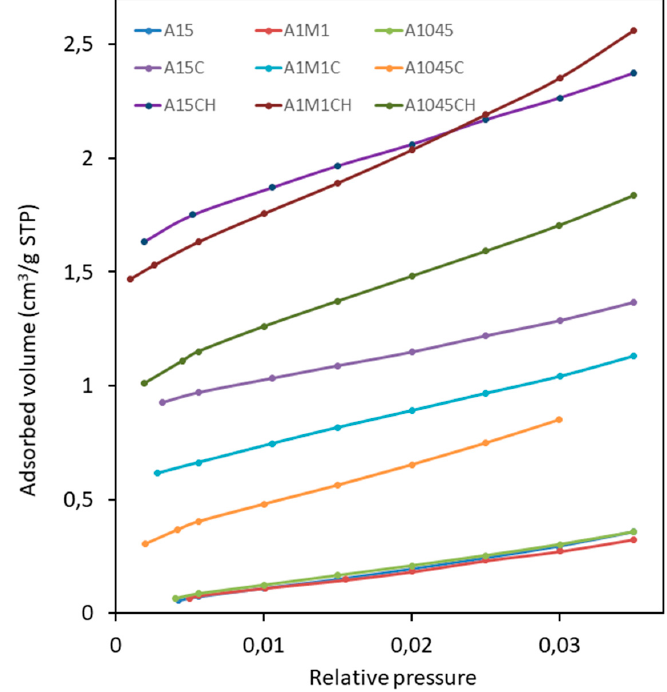
Figure 4. CO 2 adsorption–desorption isotherms for calcites: A1045, A1M1, and A15; calcites calcined: A1045C, A1M1C, A15C, and calcites calcined and rehydrated: A1045CH, A1M1CH, and